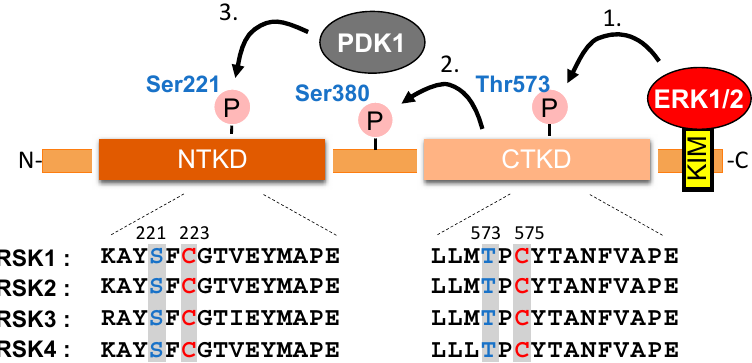
Figure 1. Schematic representation of the major functional domains and activation mechanism of RSK1. The C -terminal end of RSK1-4 contains an ERK1 / 2-docking domain resembling a KIM (kinase interaction motif), and the extreme C -terminus comprises a PDZ-binding motif. PDZ is an initialism combining the first letters of the first three proteins discovered to share the domain—post synaptic density protein (PSD95), Drosophila disc large tumor suppressor (Dlg1), and zonula occludens-1 protein (zo-1). (1) Activation of RSK is initiated by ERK docking, which is followed by the phosphorylation at Thr573 of the C -terminal kinase domain (CTKD) [5]. (2) The active CTKD phosphorylates Ser380 on a linker site between the kinase domains that creates a docking site for PDK1 [6]. (3) In the end, PDK1 activates the N -terminal kinase domain (NTKD) by phosphorylation at Ser221 [7]. The positions corresponding to functionally critical phosphorylation sites are highlighted in blue and reactive cysteine residue in the equivalent catalytic subdomain of several protein kinases are highlighted in red.